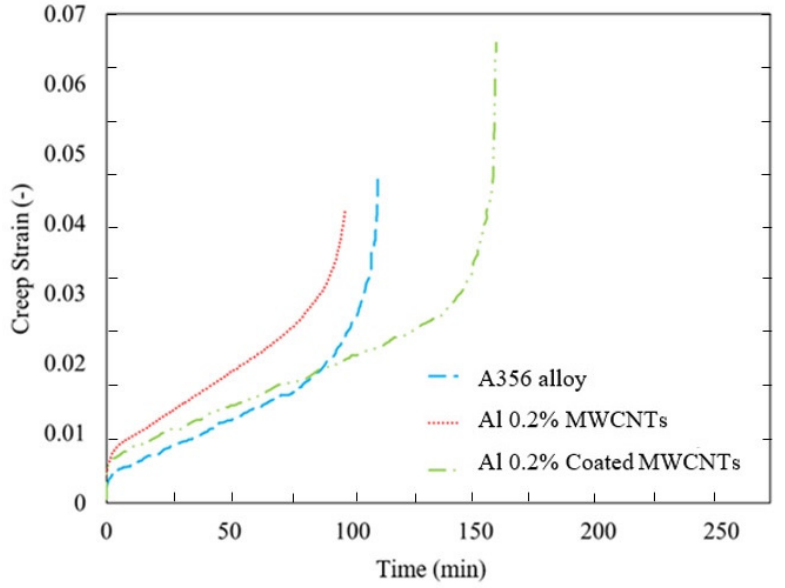
Figure 10. Creep strain diagram in time for A356 aluminum alloy and nanocomposites made with 0.2 and 0.2% Ni-coated MWCNTs.